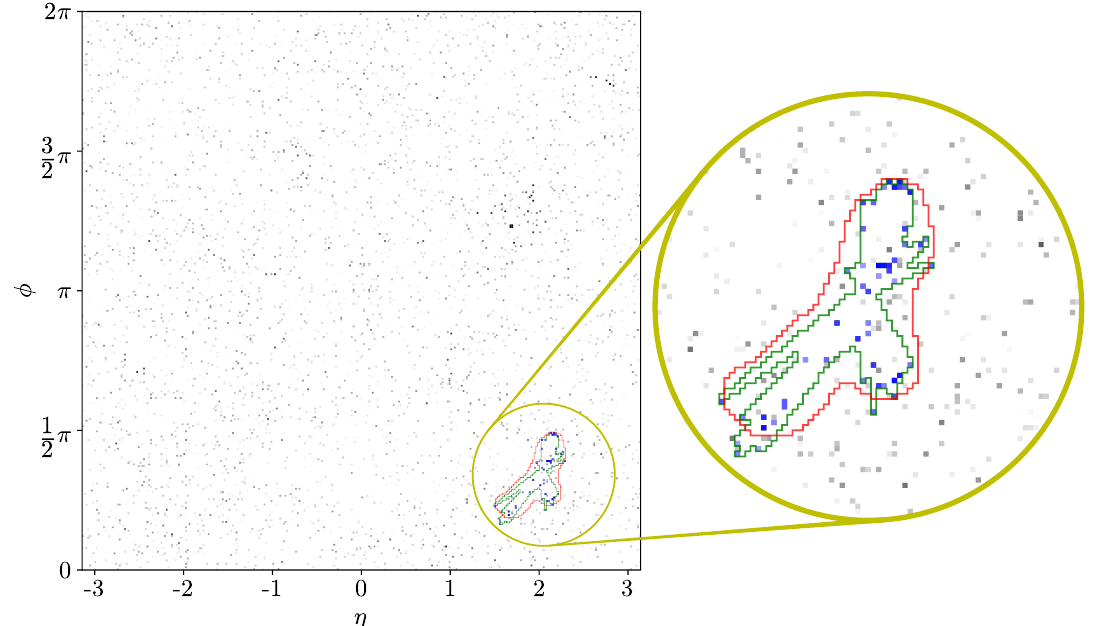
Figure 4. A typical event containing one Higgs and three QCD jets (overlaid by pileup events). Each pixel corresponds to ∆ η × ∆ φ = 0 . 020 × 0 . 020 . The grayscale of the image are inverted for better perception. Particles of the Higgs jet are highlighted in blue. The yellow circle has R = 0 . 8 , which is the minimum radius required for a C/A jet to enclose the Higgs decay products completely. This region is magnified three times for clearer visibility. The Higgs boson in this event has p T = 327 GeV. This fat jet has p T = 417 GeV and m = 209 GeV prior to any glooming procedure. The green contour indicates the input mask we constructed in radial shape, and the red one indicates the output. Note that we mandatorily enlarge the output by two pixels around its boundary as the final detection result. In this example, particles inside the enlarged contour produce a reconstruction of m = 118 GeV and p T = 329 GeV, as compared to a trimmed jet of m = 133 GeV and p T = 336